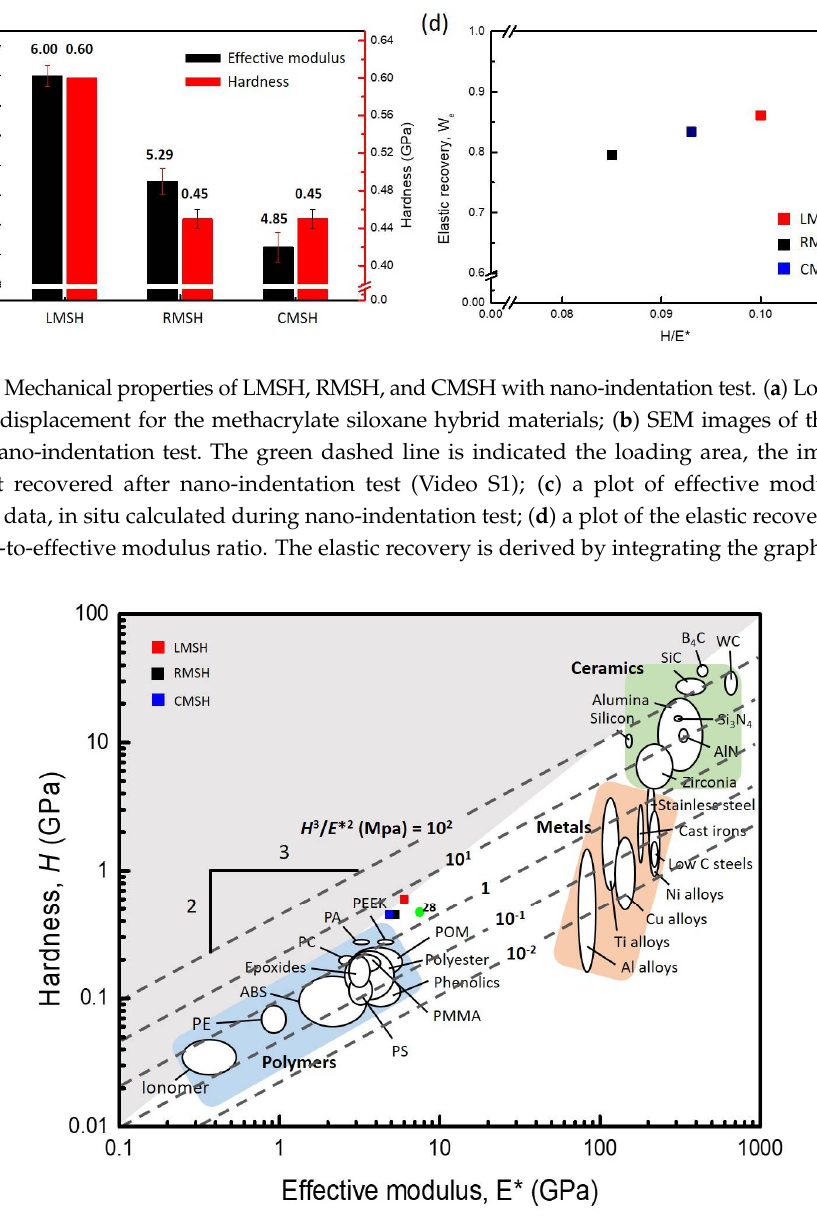
Figure 5. An Ashby map of hardness versus effective modulus for wear resistance. The LMSH only exists in the upper shaded area (H/E* ≥ 1). Values for other synthetic methacrylate-phenyl ladder-like polysilsesquioxanes are given in [31].